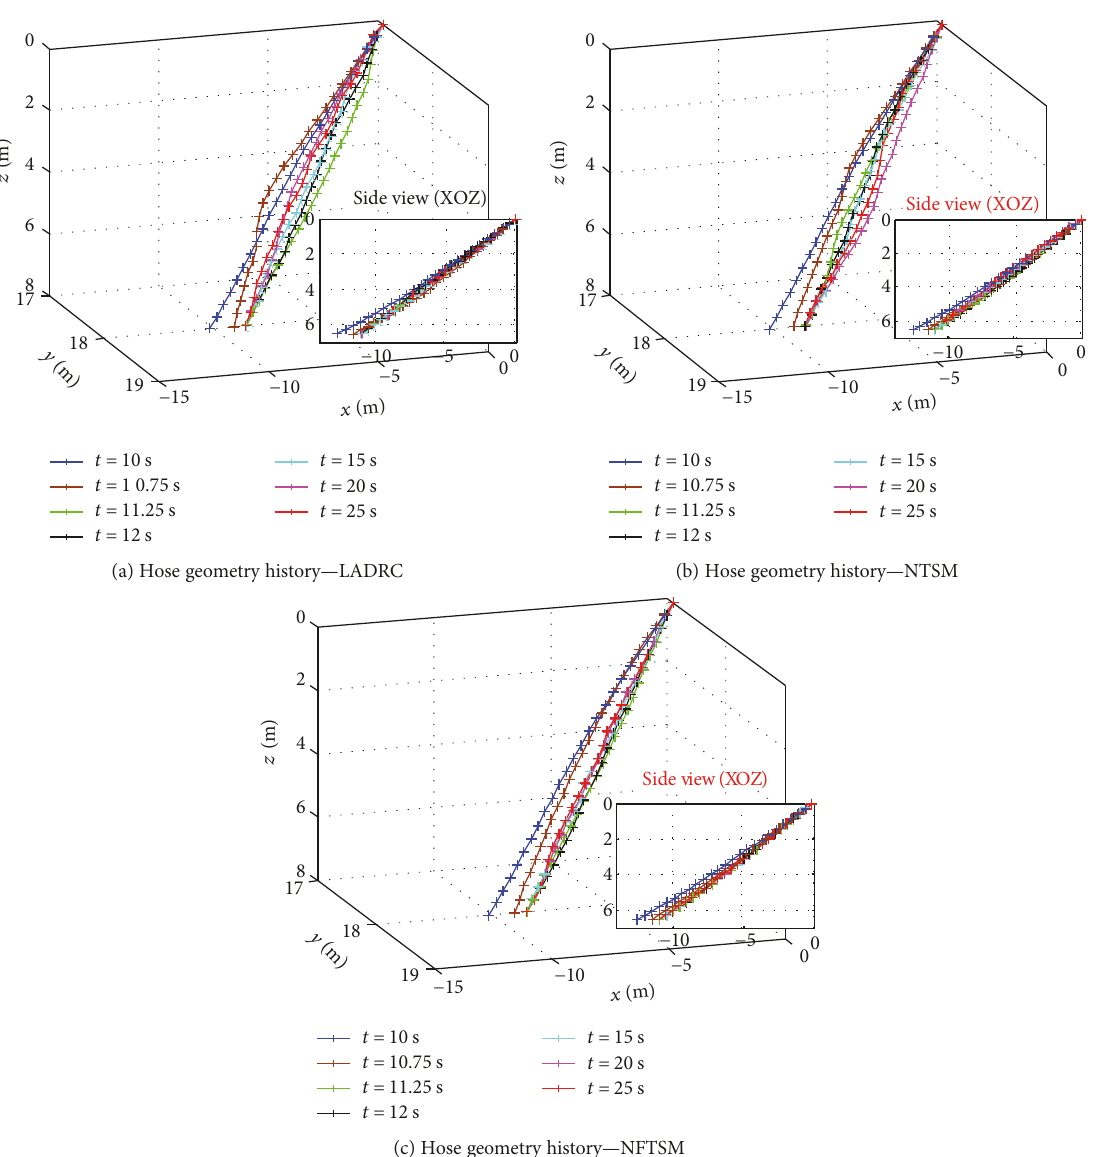
Figure 9: The hose-drogue assembly ’ s dynamic motions by di ff erent control